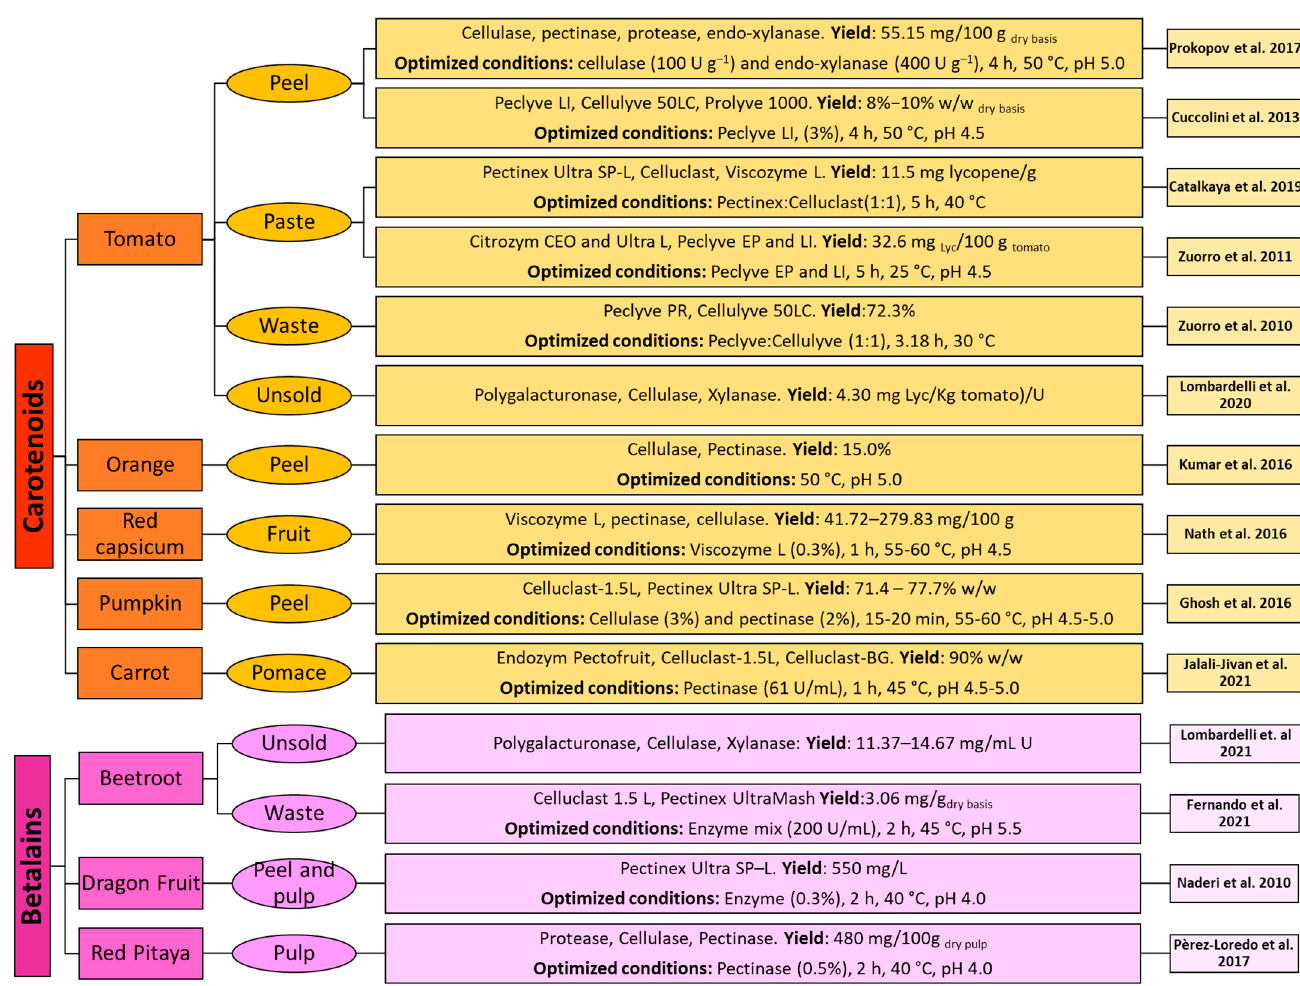
Figure 3. Enzyme − assisted extraction of carotenoids and betalains from unsold vegetables and waste. Prokopov et al. [63], Cuccolini et al. [64], Catalkaya et al. [65], Zuorro et al. [61], Zuorro et al. [66], Lombardelli et al. [67], Kumar et al. [68], Nath et al. [69], Ghosh et al. [70], Jalali − Jivan et al. [71], Lombardelli et al. [72], Fernando et al. [73], Naderi et al. [74], Pèrez Loredo et al. [57].